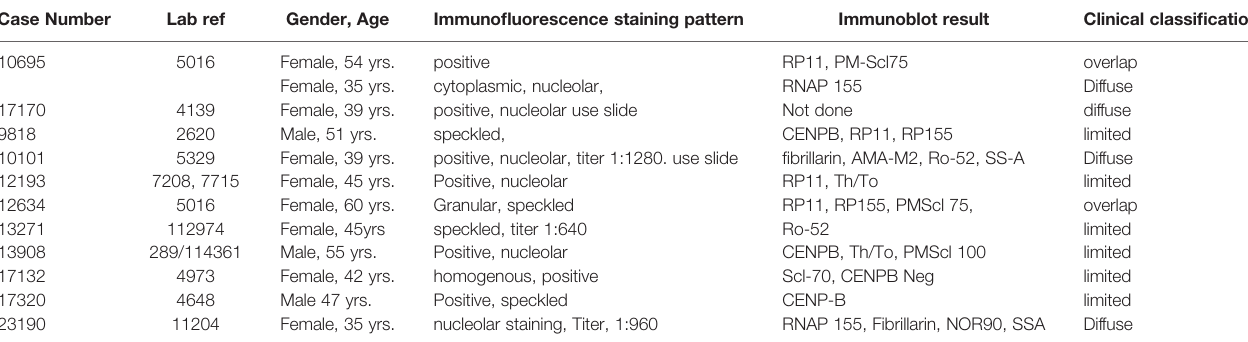
TABLE 3 | Immuno fl uorescence staining patterns and immunoblot reactivity clinical characteristics of patients ful fi lling the ACR/EULAR criteria for the diagnosis of systemic sclerosis.